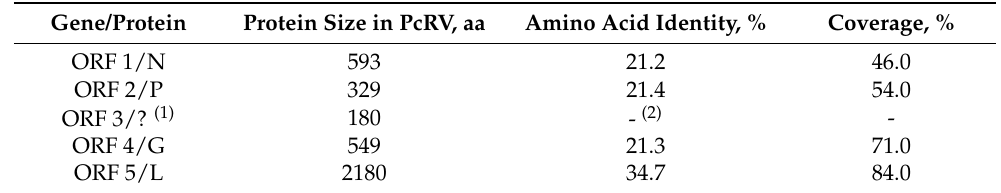
Table 1. Pairwise comparison of protein sequences for potato cyst nematode rhabdovirus (PcRV) and soybean cyst nematode virus (ScRV). Gene/Protein Protein Size in PcRV, aa Amino Acid Identity, % Coverage, % ORF 1/N 593 21.2 46.0 ORF 2/P 329 21.4 54.0 ORF 3/? (1) 180 - (2) - ORF 4/G 549 21.3 71.0 ORF 5/L 2180